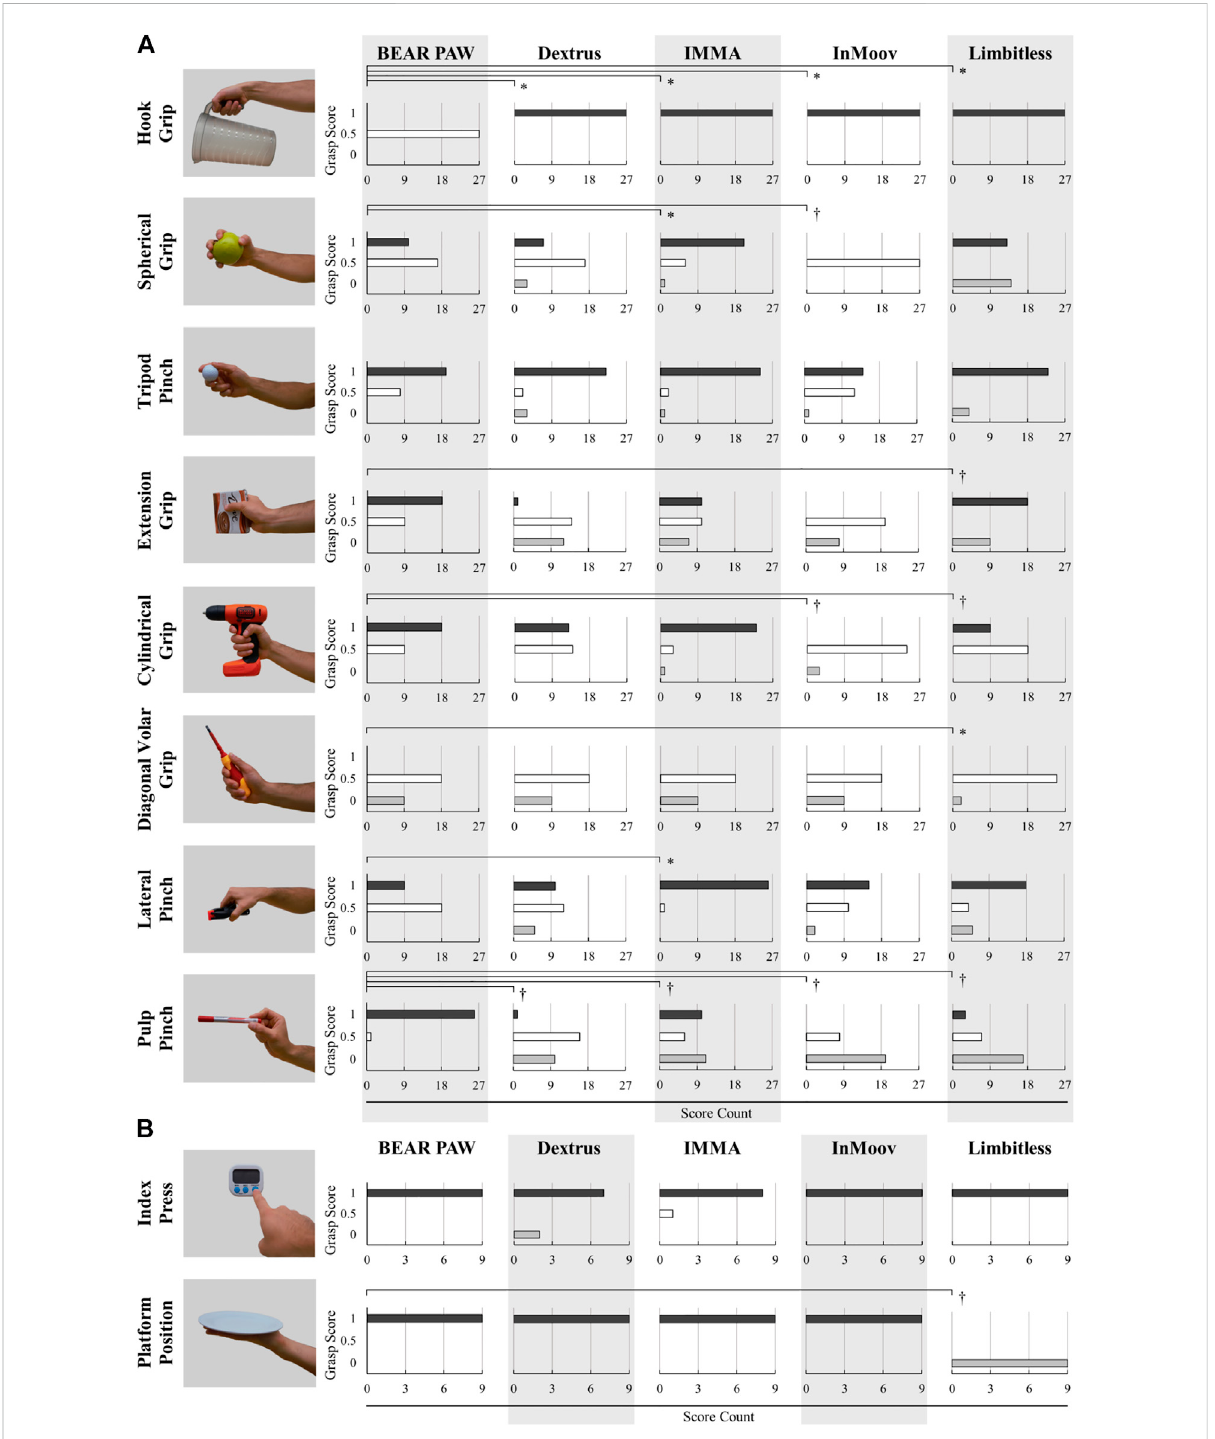
FIGURE 7 BEAR PAW grasping comparison scores for the 10 different (A) grasp types and (B) postures across the four adult hands. For each grasp type/ posture, the number of times each hand scored a 1, 0.5, or 0 was plotted. *Represents when the BEAR PAW performed statistically worse. † Represents when the BEAR PAW performed statistically